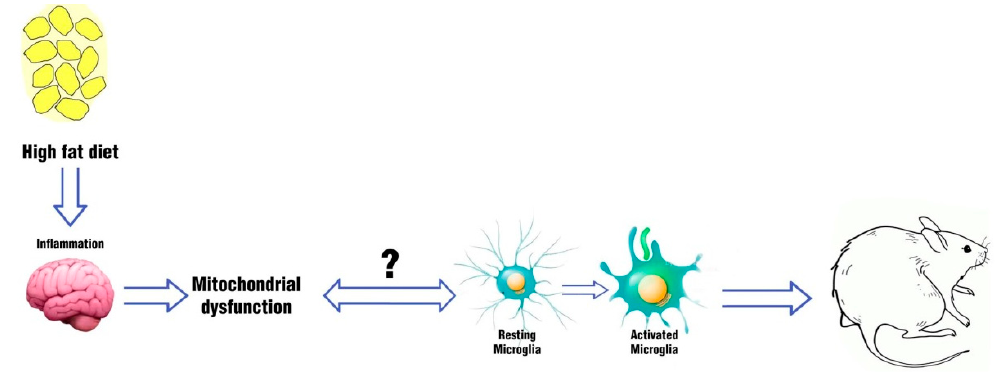
Figure 3. E ff ects of inflammation induced by a diet rich in fats on the non-neuronal cell Figure 3. Effects of inflammation induced by a diet rich in fats on the non-neuronal cell population.